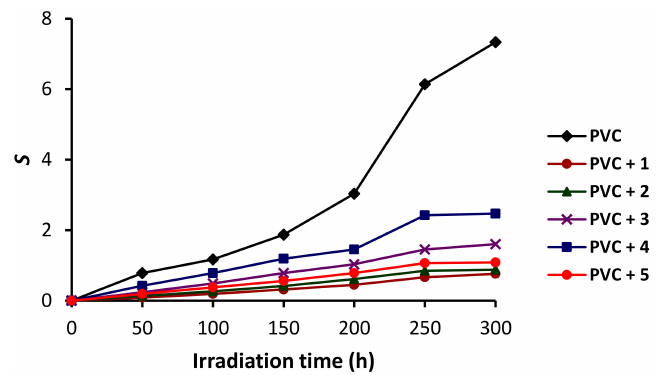
Figure 8. Changes in the S values of PVC upon